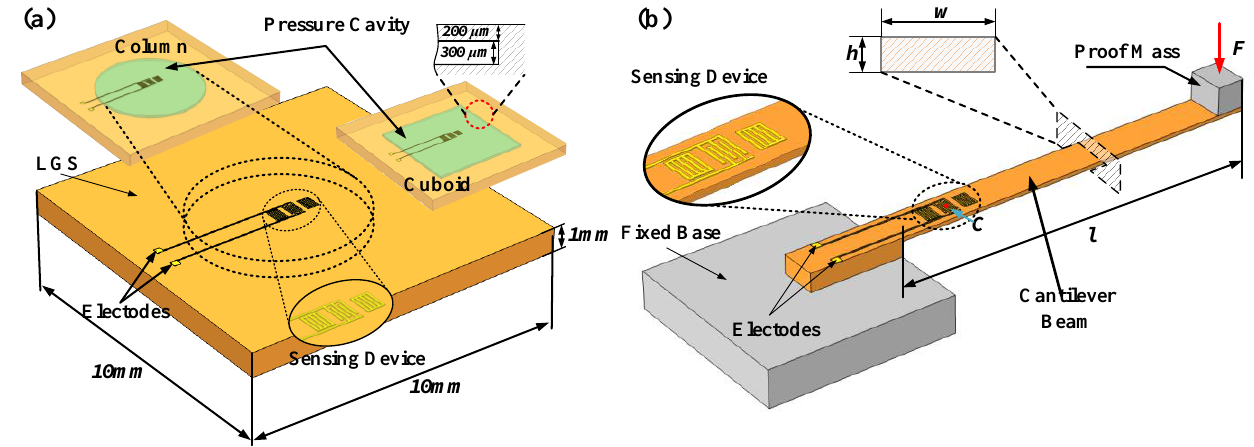
Figure 1. Diagram of the ( a ) pressure sensing device and ( b ) vibration sensing device.